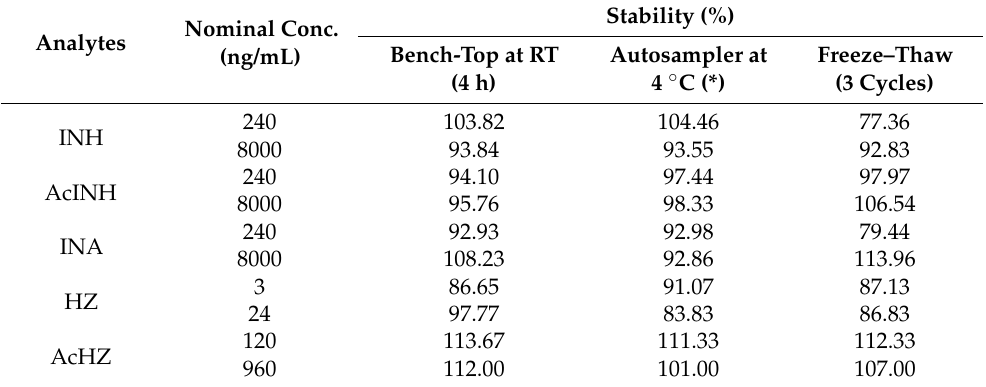
Table 4. Stability of all